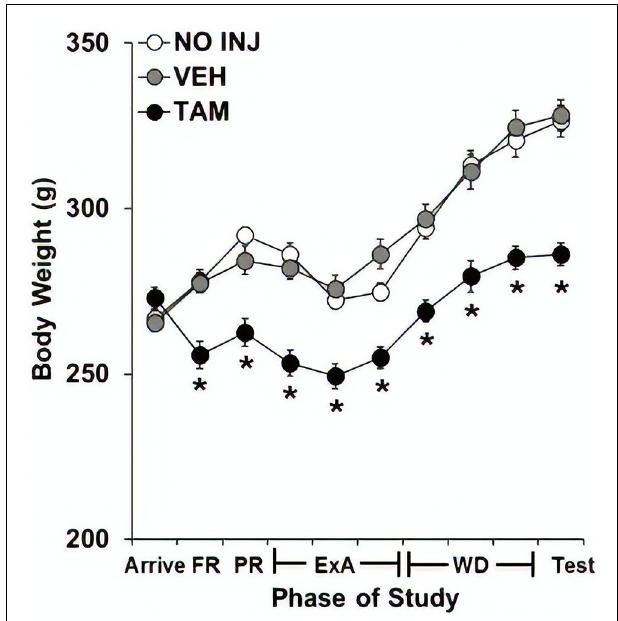
FIGURE 5 | Tamoxifen decreased body weight. Mean ( ± SEM) body weight across 10 phases of study for the no-injection (NO INJ, n = 18), vehicle (VEH, n = 24), and tamoxifen (TAM, n = 20) groups. ∗ Significant difference between the VEH and TAM groups ( P ’s < 0.0001). FR, fixed ratio; PR, progressive-ratio; ExA, extended-access; WD,